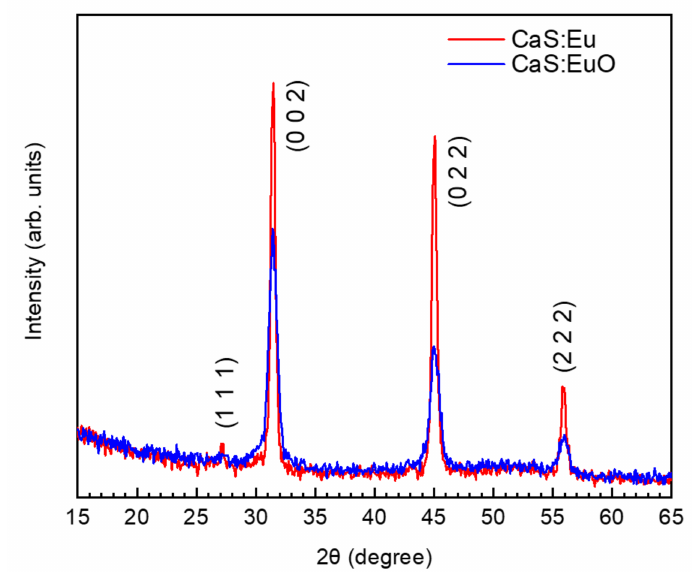
Figure 2. Grazing incidence XRD of CaS:Eu and CaS:EuO